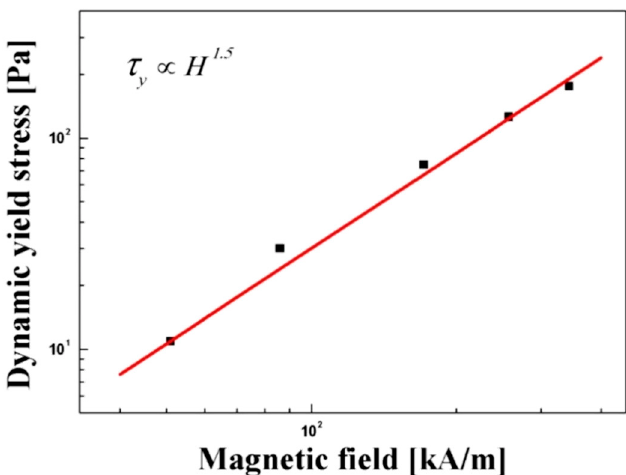
Figure 8. Dynamic yield stress as a function of magnetic field.